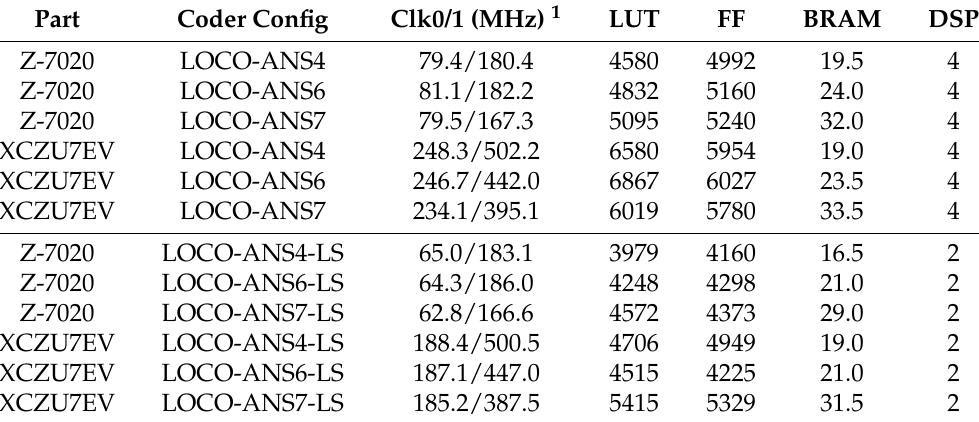
Table 3. LOCO-ANS Encoder implementation metrics for a series of configurations and target parts.